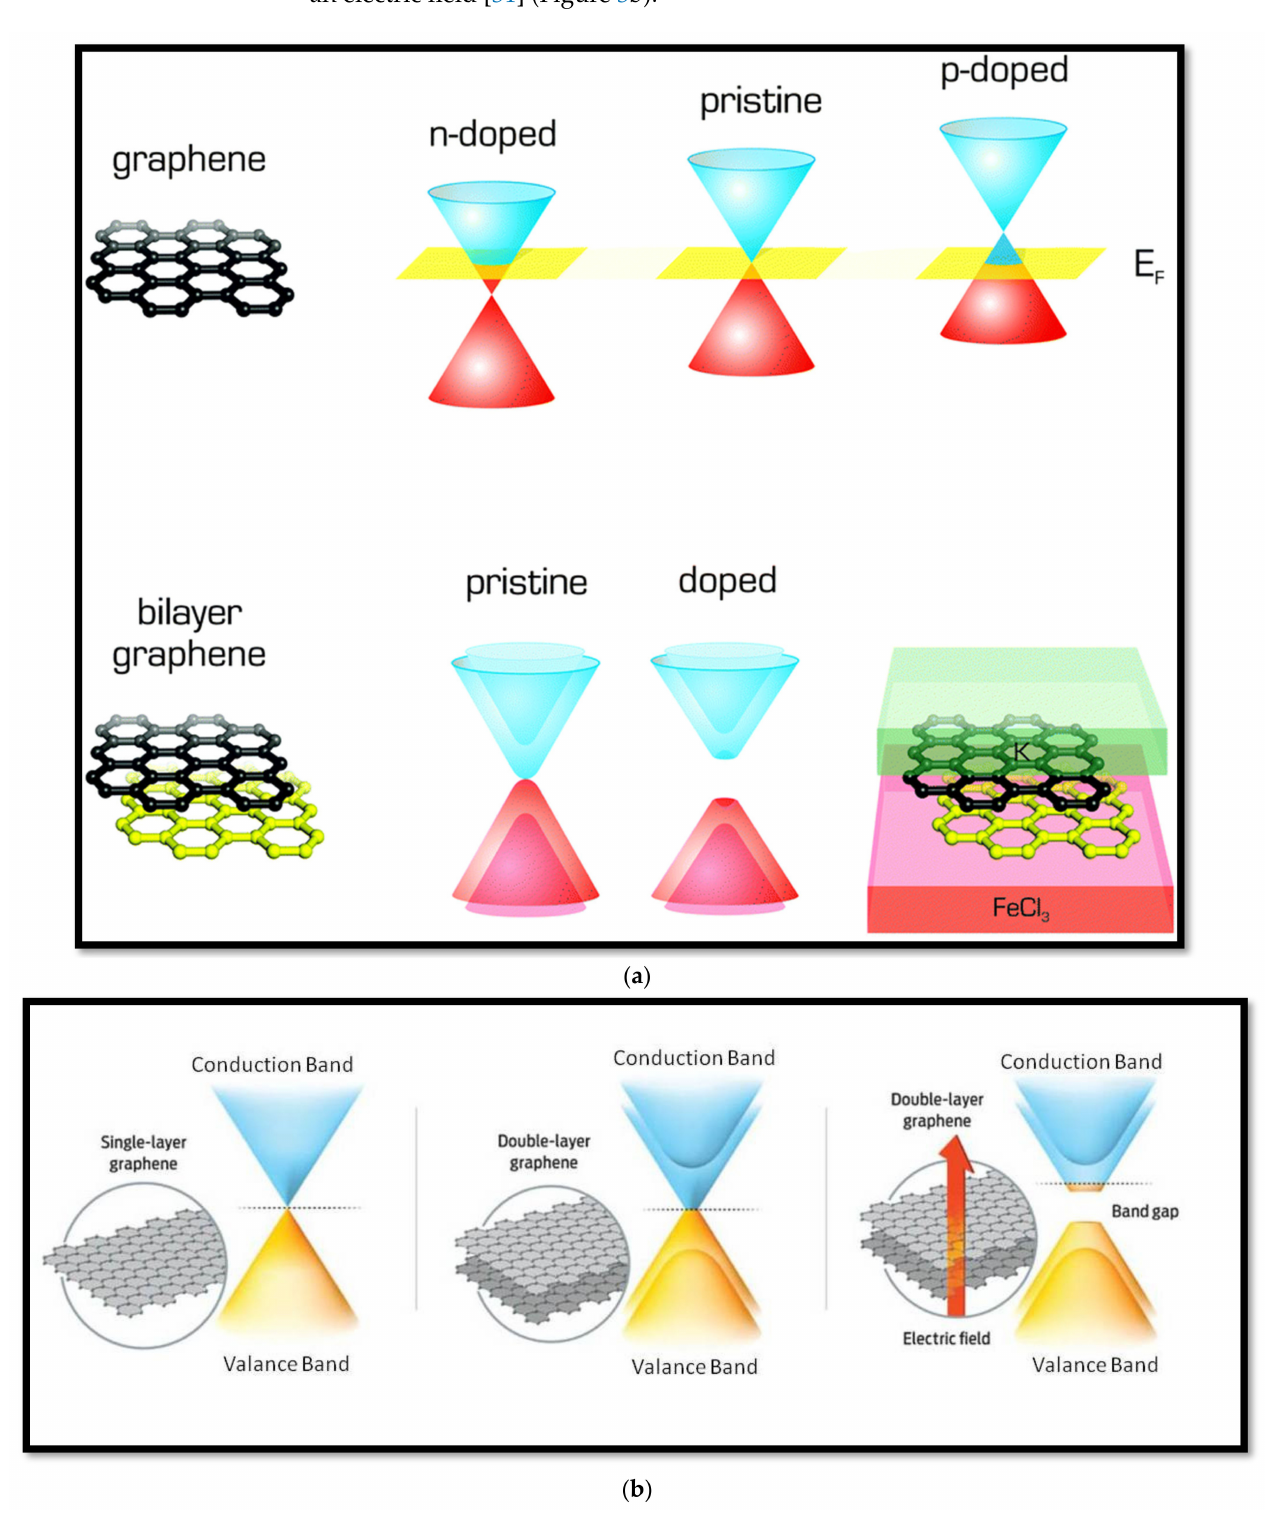
Figure 3. Similar to a single layer, a pristine bi-layer has no band gap, but a gap can be created through proper doping ( a ) or electric field application ( b ). (Reproduced with permission from refs